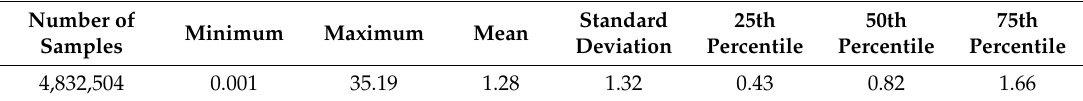
Table 1. Descriptive statistics of EE consumption.